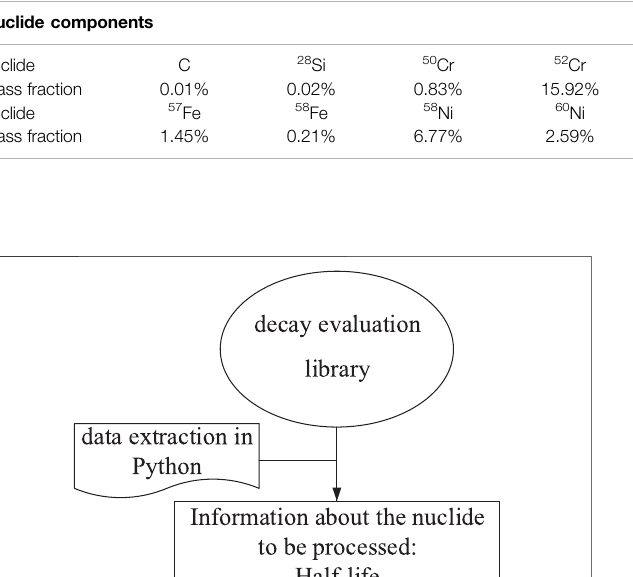
TABLE 2 | Nuclide composition of 6,115 structural